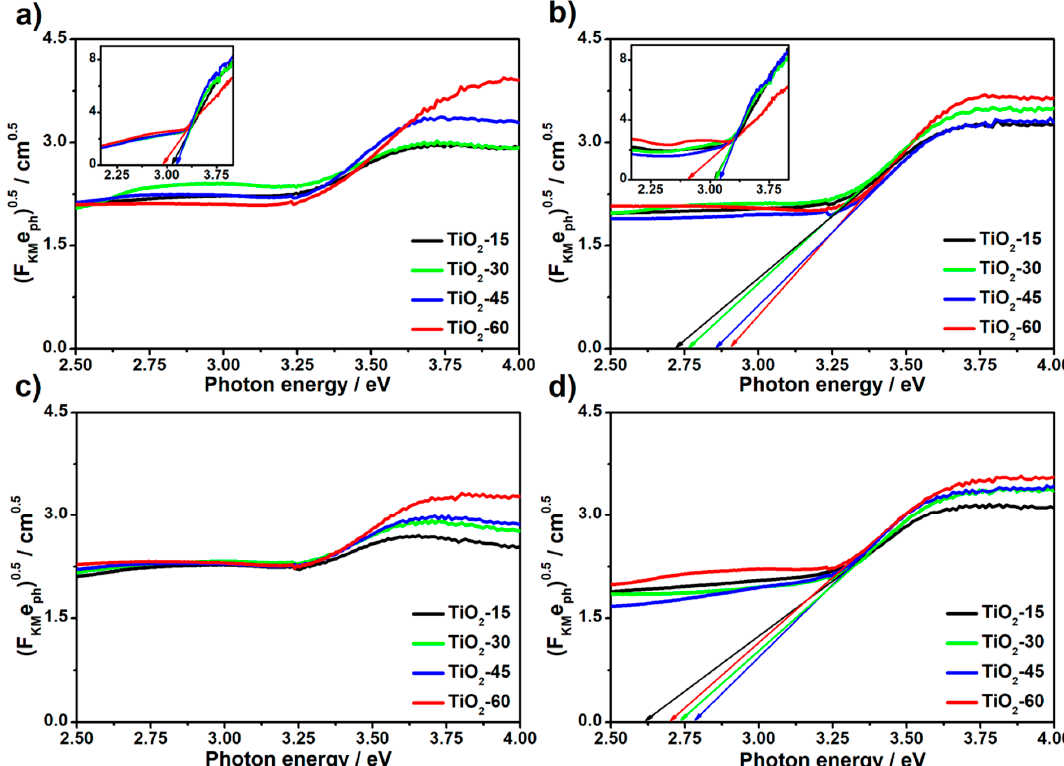
Figure 6. Tauc plots for as-anodized (a,c) and calcined (b,d) TiO 2 NTs laser-processed in the air (a,b) and under vacuum (c,d). Insets in Figure 6a,b represent unmodified as-anodized and calcined samples, respectively. Table 2. Optical bandgap values determined from the Tauc plot curves shown in Figure 6.